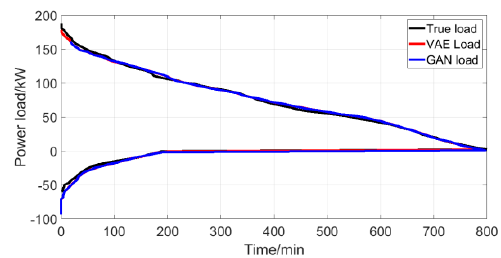
Figure 9. Duration of load profiles.